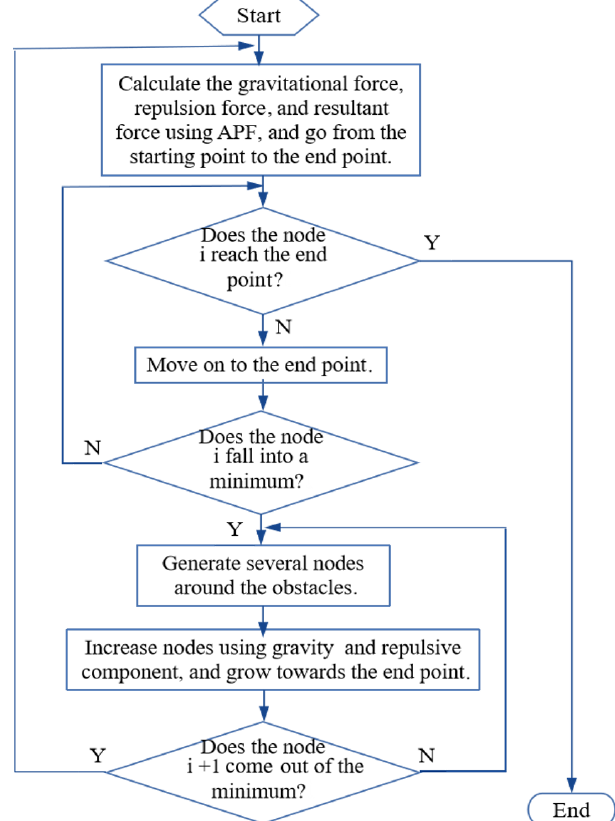
Figure 7. Path-planning process based on the improved APF